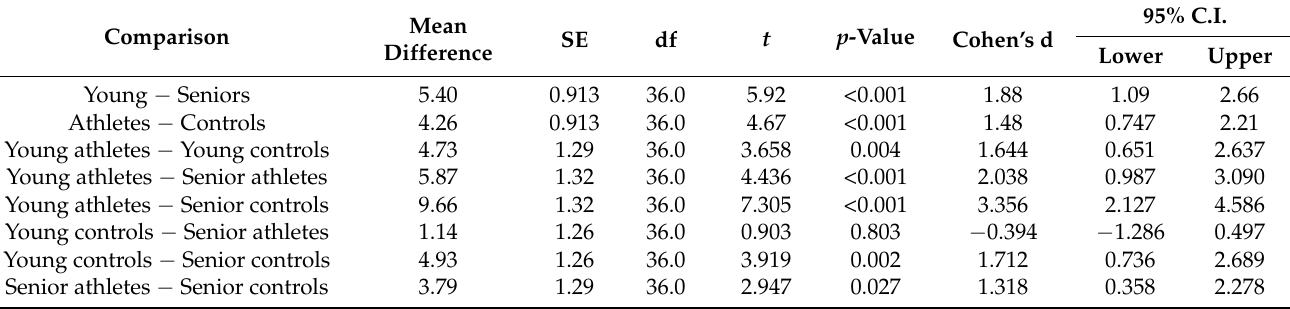
Table 3. ANOVA results for hopping height.